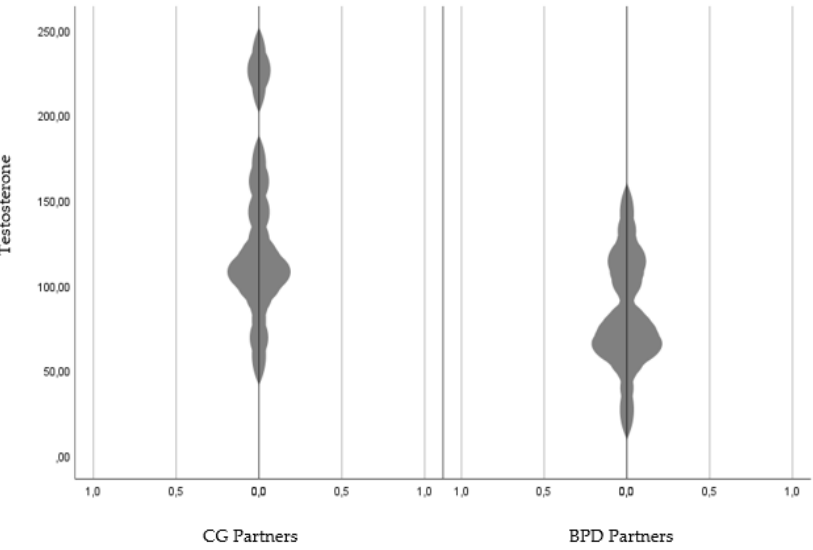
Figure 1. Testosterone levels in BPD partners compared with CG partners. Note: CG = Control group; BPD = Borderline personality